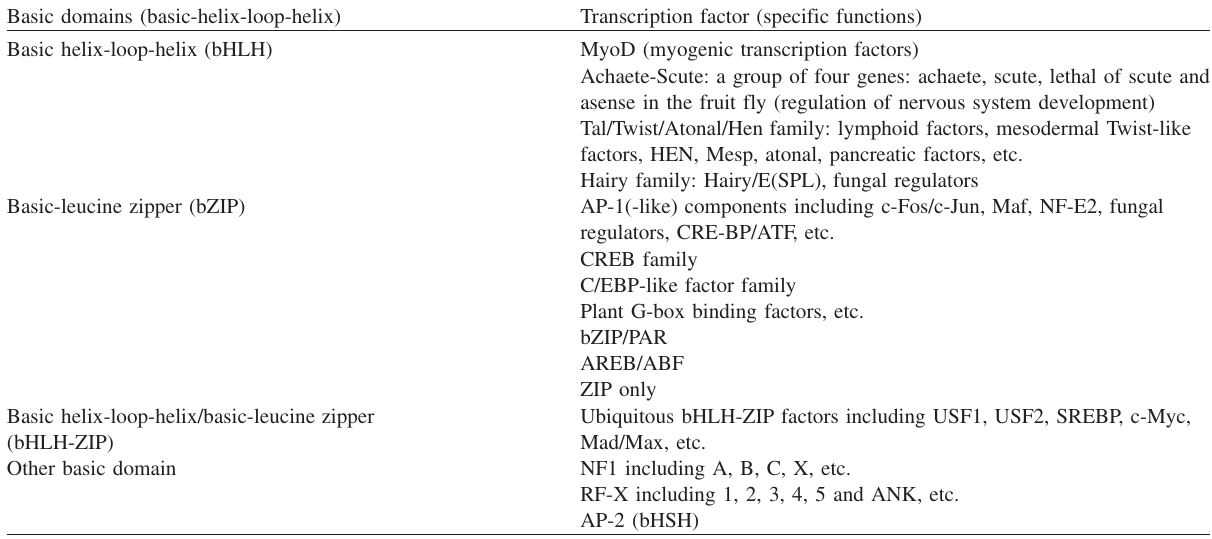
Table 1 Transcription factors with basic